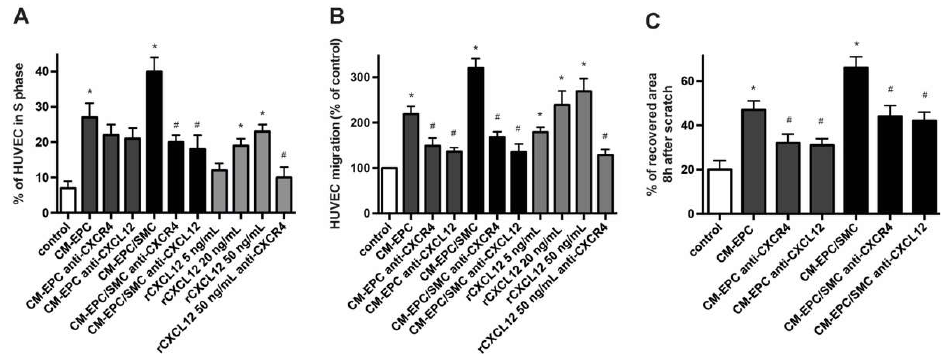
Figure 4. Engagement of CXCL12–CXCR4 in proliferation and migration of endothelial cells. ( A ) Flow-cytometry-based cell cycle analysis of HUVECs treated for 24 h as indicated. * p < 0.05